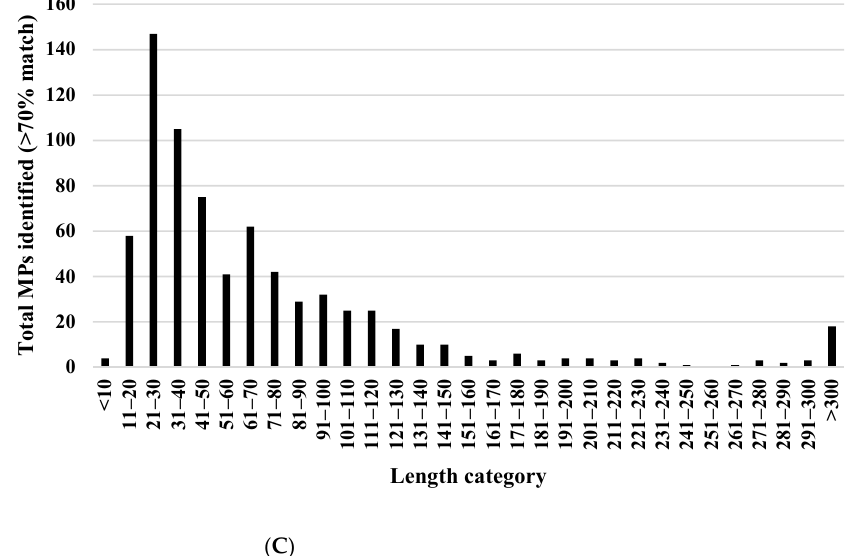
Figure 3. MP characteristics observed in the atmospheric samples obtained from sampling Site 1 (A63): ( A ) shape, ( B ) length, and ( C ) width. The overall MP polymer composition of samples detected across the 13-month study at Site 1 (A63) samples was predominantly PE (31%) and nylon (28%), with 25 different polymer types identified (Figure 4). Overall, MPs accounted for 26% of the particles that were identifiable. Film-shaped MPs were predominantly PE (42%) and nylon (35%). Fragmented MPs displayed a more varied MP polymer type, with PET (15%), PP/PE (11%), PE (10%), nylon (9%), PTFE (9%), and resin (9%) the most abundant. Fibrous MPs were predominantly nylon (32%), PE (16%), PET (9%), and acrylic (9%).